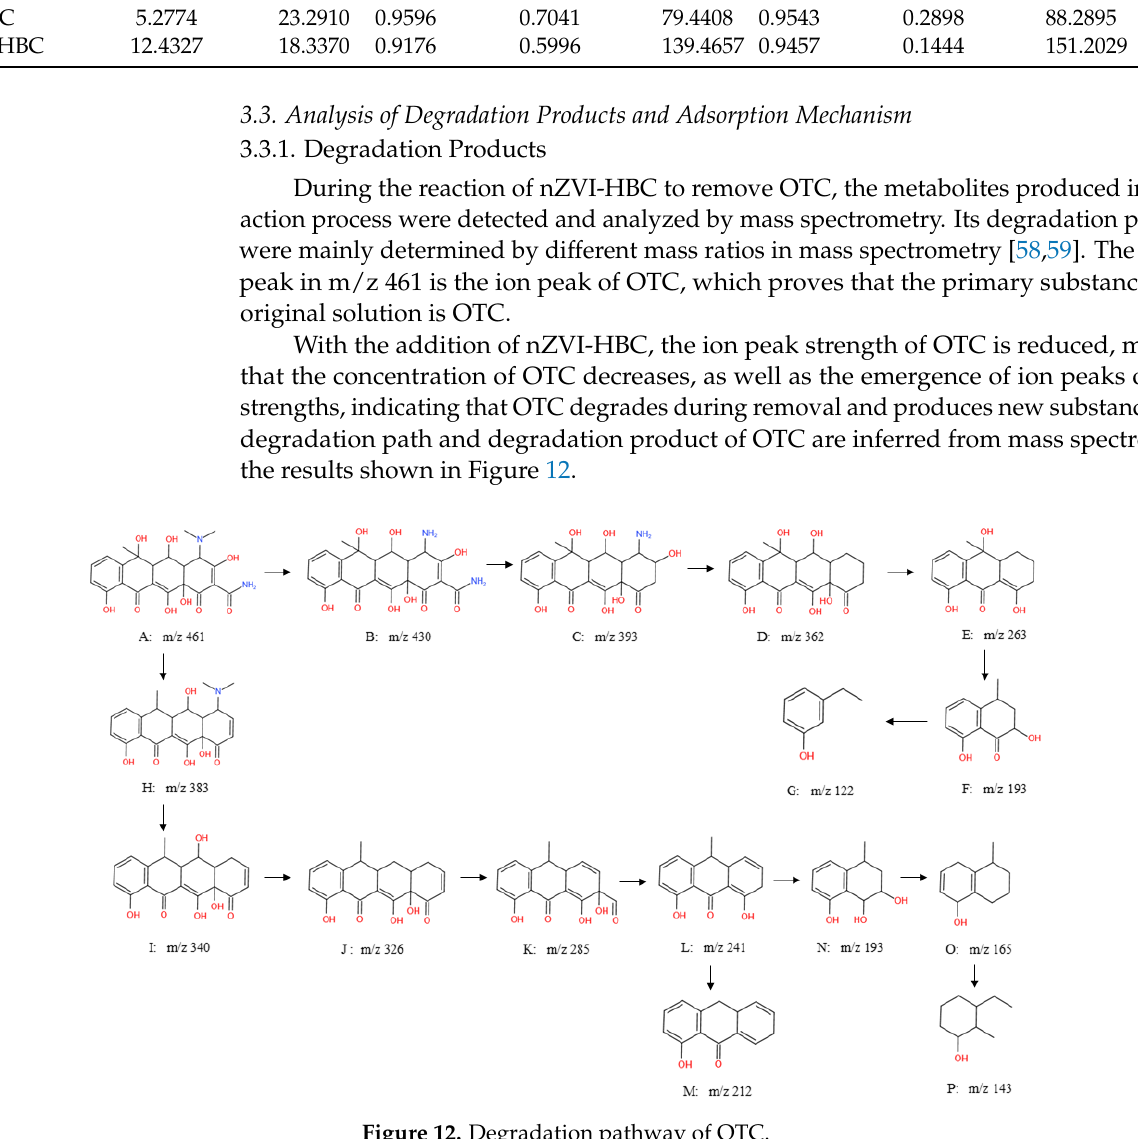
Figure 11. Adsorption kinetics curves of OTC adsorption of BC, HBC, and nZVI-HBC. ( a ) pseudo- first-order and pseudo-second-order dynamics model. ( b ) intra-particle diffusion model